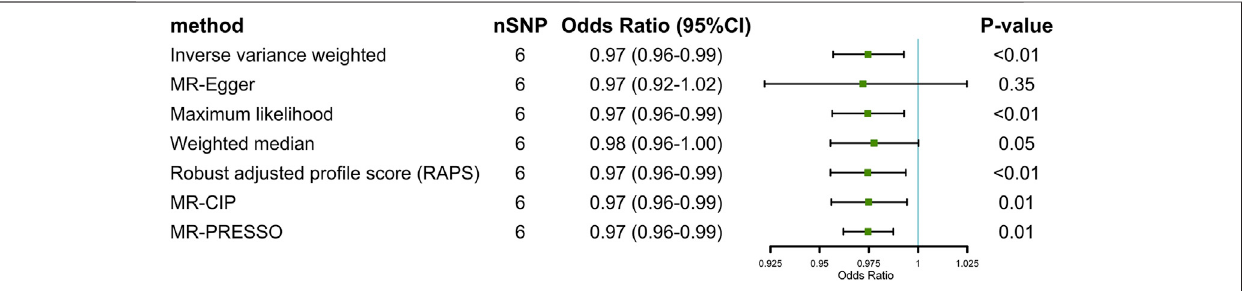
FIGURE 2 | Two-sample Mendelian randomization estimations of the causal effect of gluten-free diet on irritable bowel syndrome with IVW, MR Egger, ML, WME, RAPS, MRCIP, and MR PRESSO (at p < 1 × 10 – 5 ).